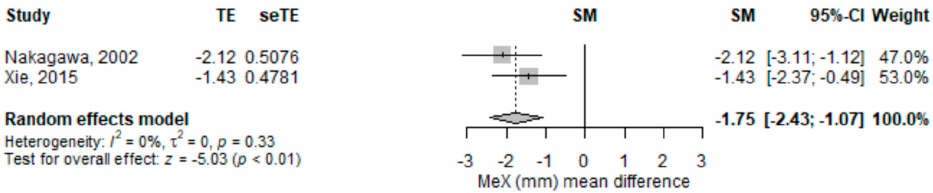
Figure 4. Forest plot for (mm) standardized mean change difference. MeX − distance from menton to midline; TE − effect; seTE—effect’s standard error; SM − the average discrepancy; CI-interval of confidence.